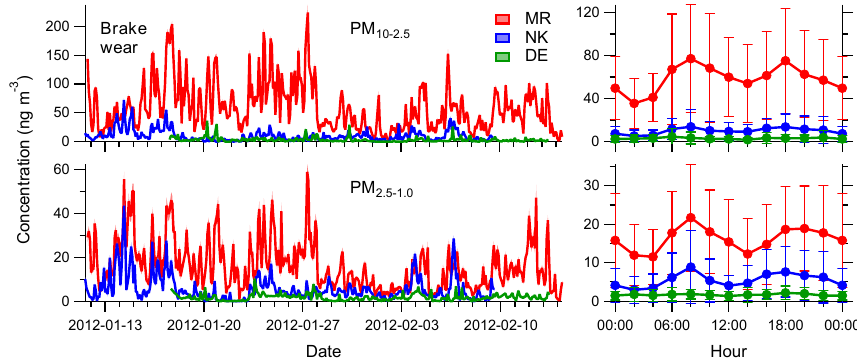
Figure 4. Time series (left) and diurnal variations (right) of the brake wear factor at MR, NK and DE for PM 10–2 . 5 and PM 2 . 5–1 . 0 . Time series show the mean of all good solutions ± 1SD as shaded areas. Diurnals show the mean of the time series ± 1SD as whiskers, with the hour being the start of a 2h sampling period (00:00UTC means sampling from 00:00 to 02:00UTC).